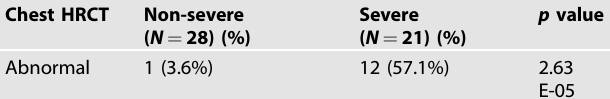
Table 2. Comparison of Chest HRCT between Non-severe and Severe Groups 6 months after